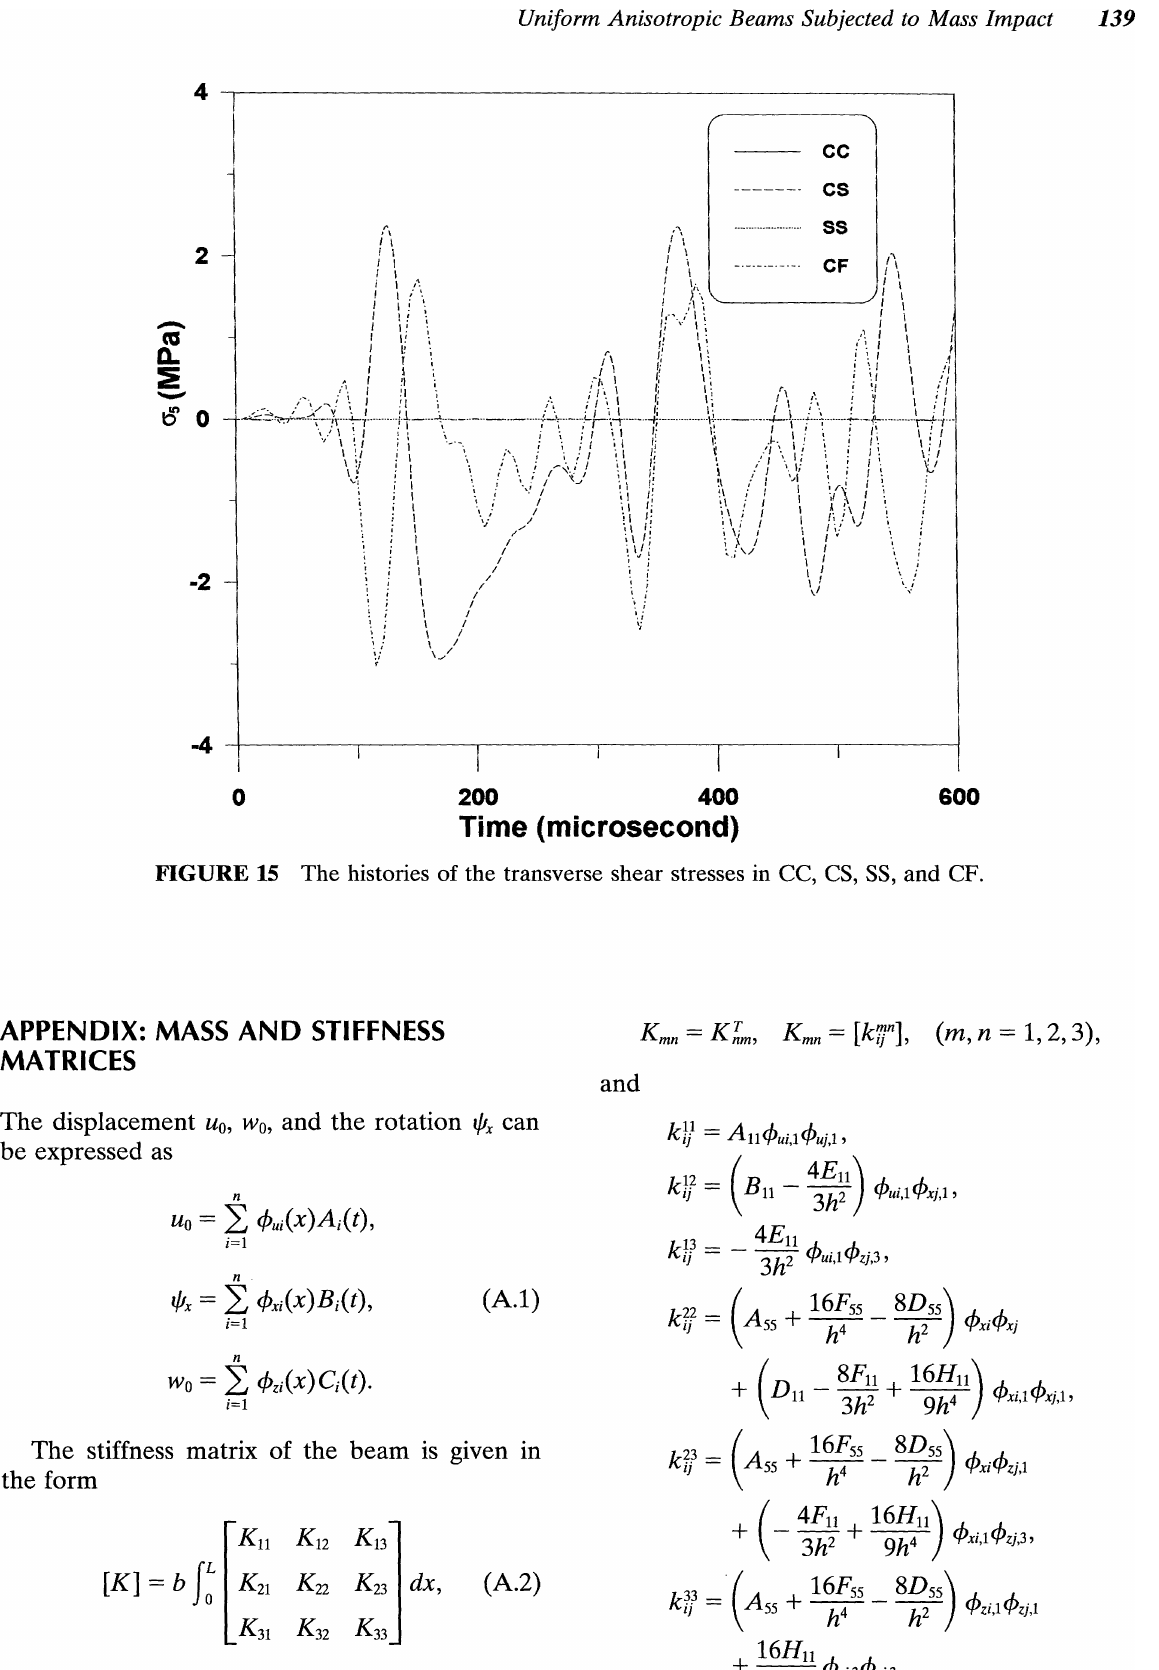
FIGURE 15 The histories of the transverse shear stresses in CC, CS, SS, and